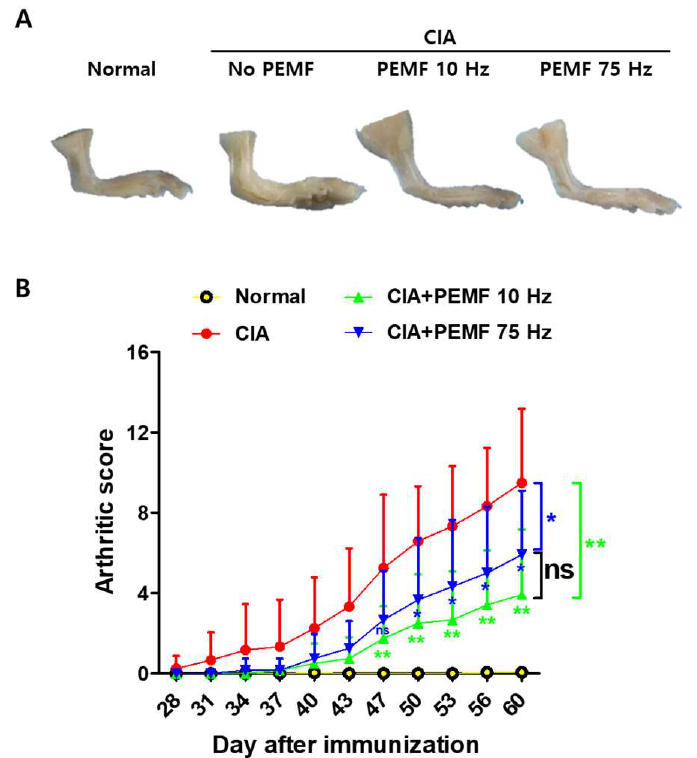
Figure 1. Effects of PEMF on CIA progression in mice. The severity of arthritis in CIA mice was evaluated by determining the clinical arthritis score beginning from 7 days after the second immunization (i.e., day 28). ( A ) Macroscopic appearance of the ankle joint. ( B ) Arthritic score. Grouped quantitative data of arthritic scores are presented as mean ± SD. Normal, n = 12; CIA, n = 12; CIA+PEMF 10 Hz, n = 12; CIA+PEMF 75 Hz, n = 12. Data were pooled from two independent experiments. Significance was measured using a two-tailed Student’s t -test. Significance levels were * p < 0.05 and ** p < 0.01, while ns means the results were not significant.